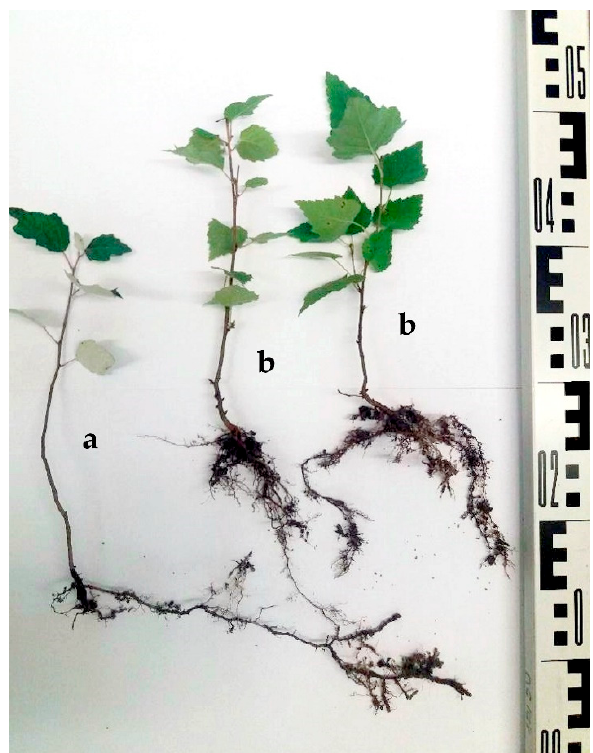
Figure 5. Examples of 2-year-old vegetation specimens growing on experimental road sections: grey poplar ( a ) and silver birch ( b ). Overground parts (shoots) and root systems are shown. The average weight of grey poplar was: 2.3 g, and silver birch 3.1; the weight of above-ground and underground parts were: 1.1 g and 1.2 g respectively for grey poplar; 2.0 g and 1.1 g for silver birch (Photo: A. Czerniak).